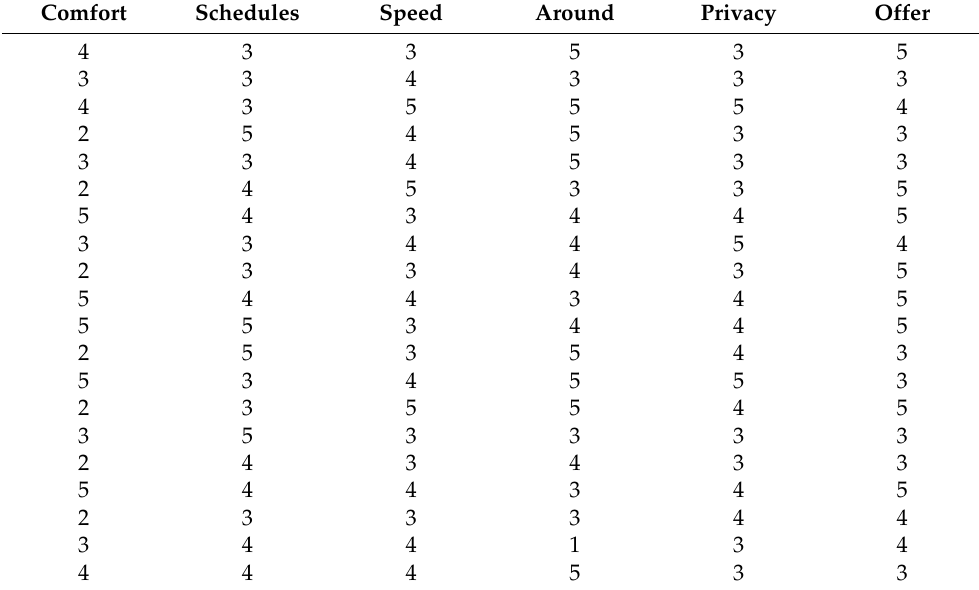
Table 1. Variables identified in the review of previous works with a sample of data collected through surveys.